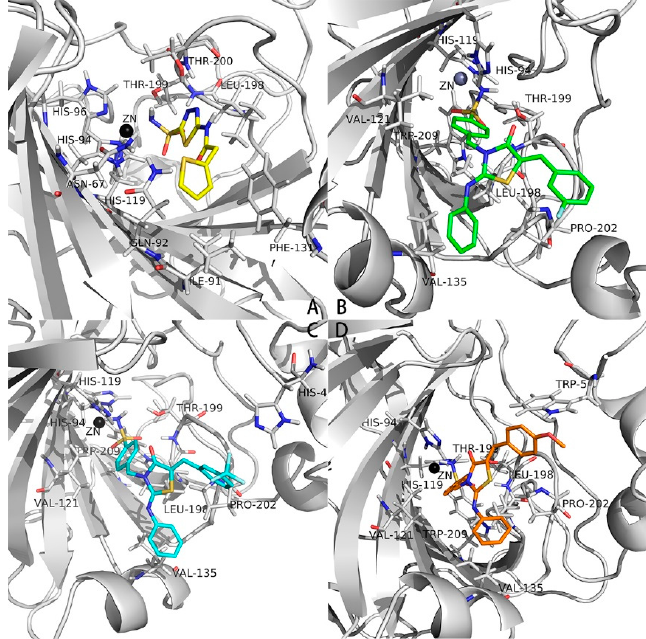
Figure 3. The study of binding mode within CA II. ( A ) 4IWZ-ref (yellow) ( B ) compound ( 4 ) (green) ( C ) compound ( 7 ) (cyan) ( D ) compound ( 11 ) (khaki). As shown in part A of Figure 3, compound